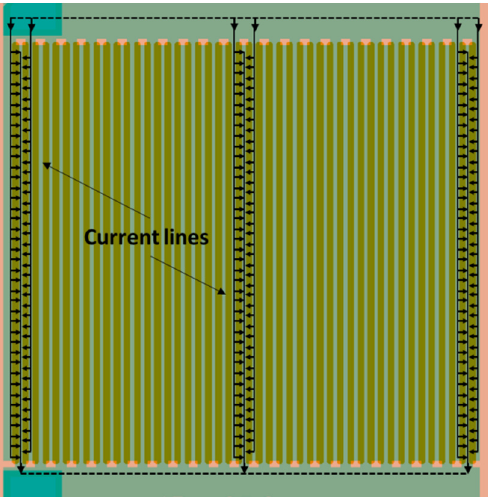
Figure 4. Example of structure of the new sensing platform with 46 pairs of diodes.